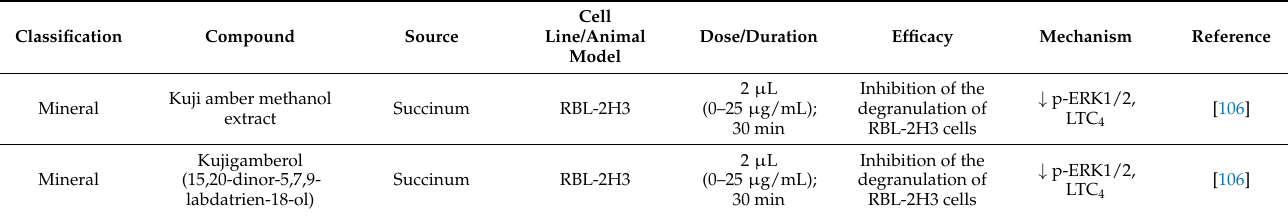
Table 3. In vitro studies—fungi and minerals-originated natural products.